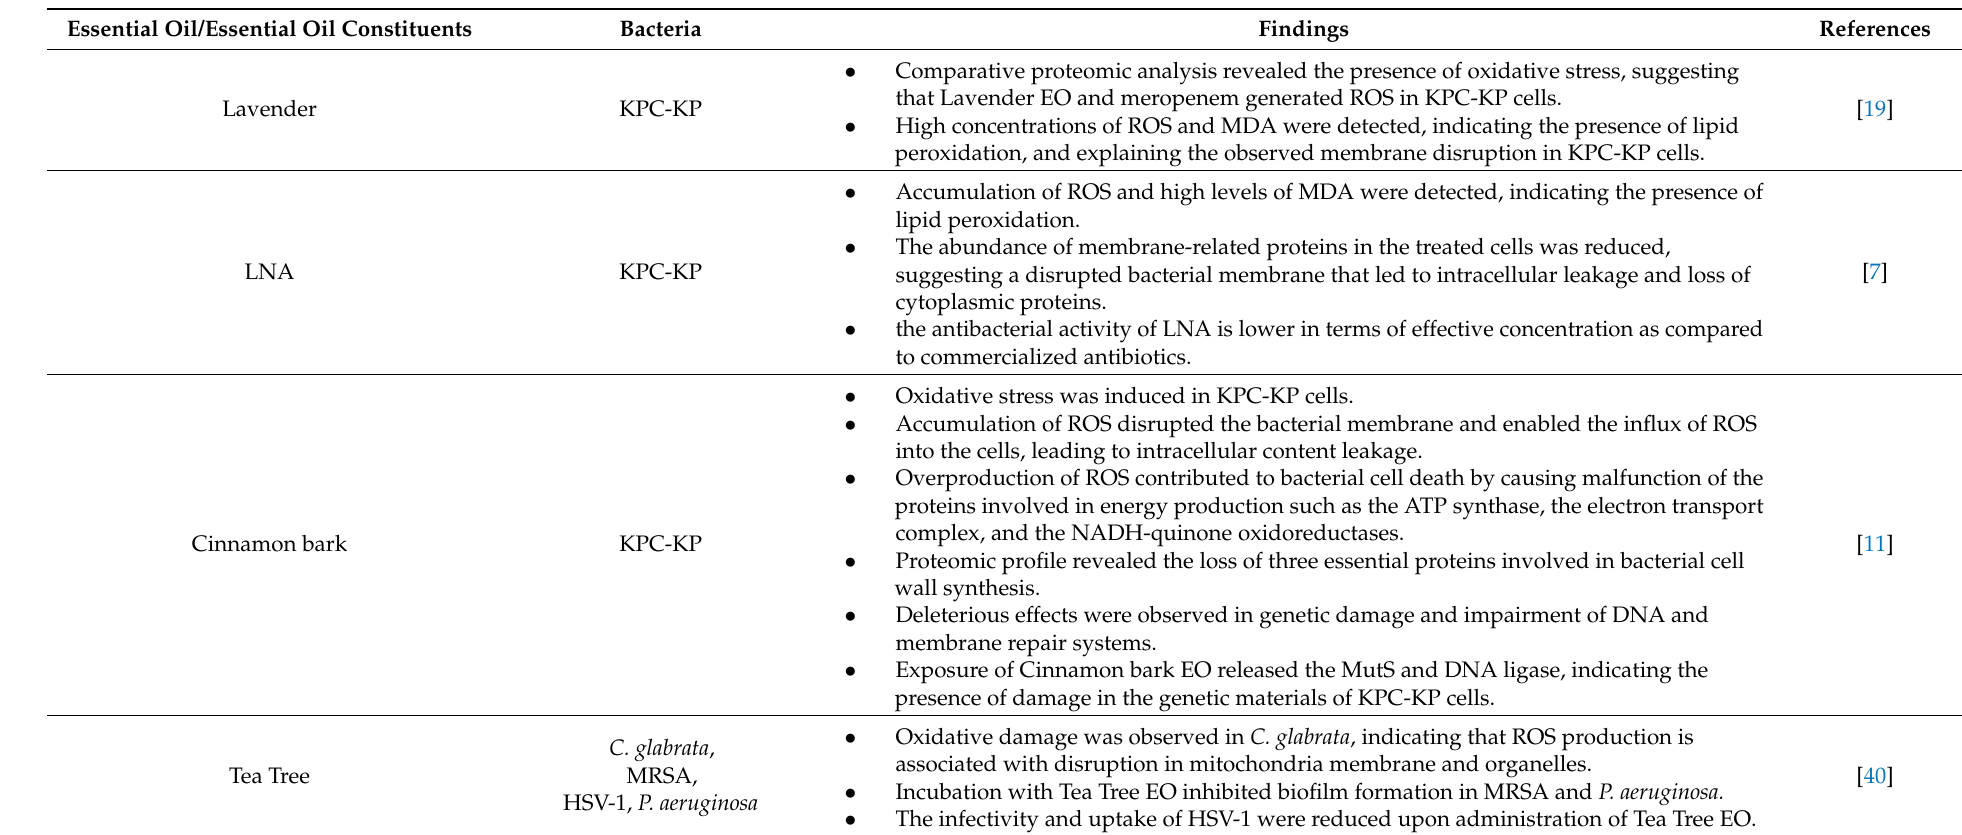
Table 1. Recent insight of pro-oxidant activity of EOs against